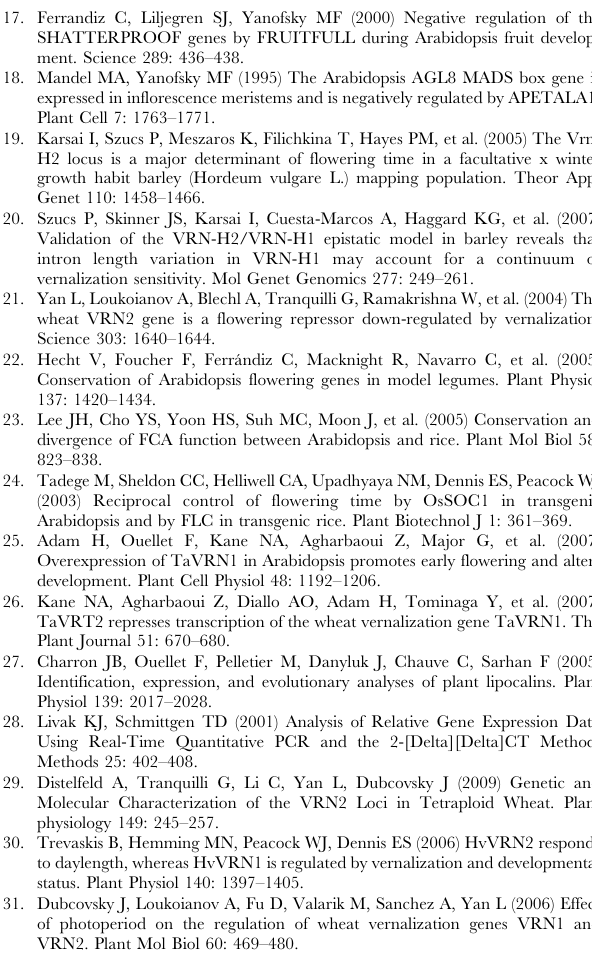
Figure S1 Effect of TaVRN-B2 over-expression on the accu- mulation of cold-regulated transcripts. A) Transcript level of CBFs genes. Control (35S::GUS) and transgenic 35S::TaVRN-B2 plants (line 1) grown under long day conditions and exposed to 4 u C for 3 and 6 hours. B) Transcript level of CORs genes. Control (35S::GUS) and transgenic 35S::TaVRN-B2 plants (line 1) grown under long day conditions at 4 u C for 1 and 2 weeks. Panels A and B are scanned for densitometry measurement. Relative expression is normalized in relation to the expression of CBF-2 of transgenic 35S::TaVRN-B2 exposed to 4 u C for 3 hours (panel A) and to the expression of COR 15a of transgenic 35S::TaVRN-B2 exposed to 4 u C for one week (panel